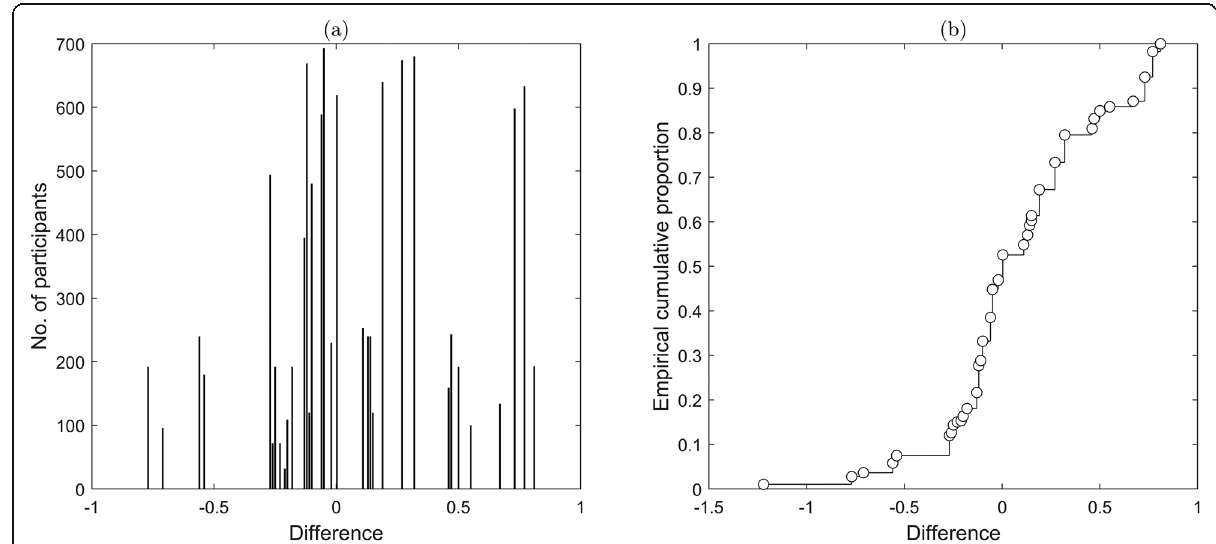
Fig. 5 Summary plot of the observed difference in underlying discriminability between simultaneous and sequential presentation. a Histogram plot. Each bar corresponds to an observed difference. The length of the bar equals the number of participants on which the estimate is based. b Empirical cumulative distribution plot. The same data plotted as an